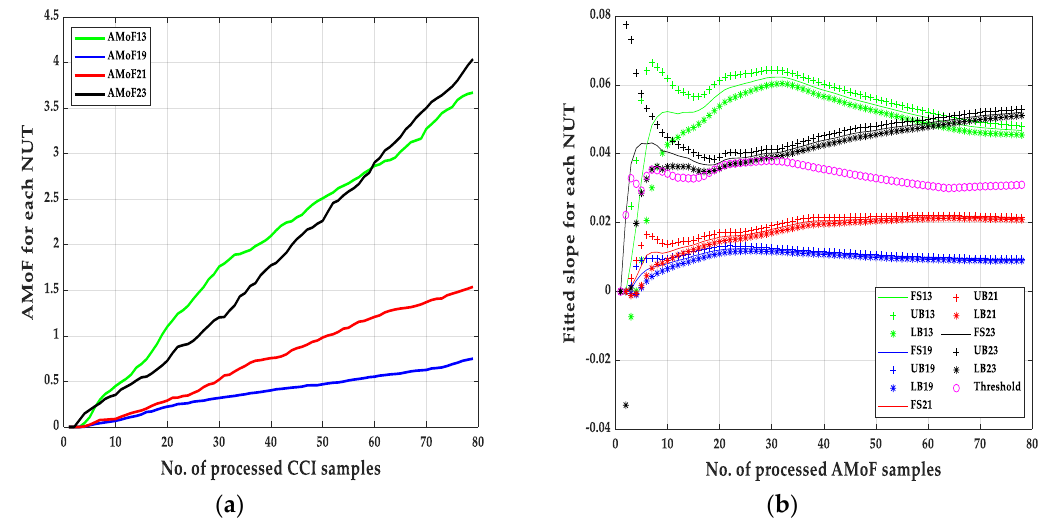
Figure 9. The AMoF and the fitted slope for different nodes for scenario NS1P3: ( a ) The AMoF for different NUT; ( b ) the fitted slope for NS1P3_FL_GM 25/5. Table 9 Performance characterization for NS1P3_FL_GM 25/5.